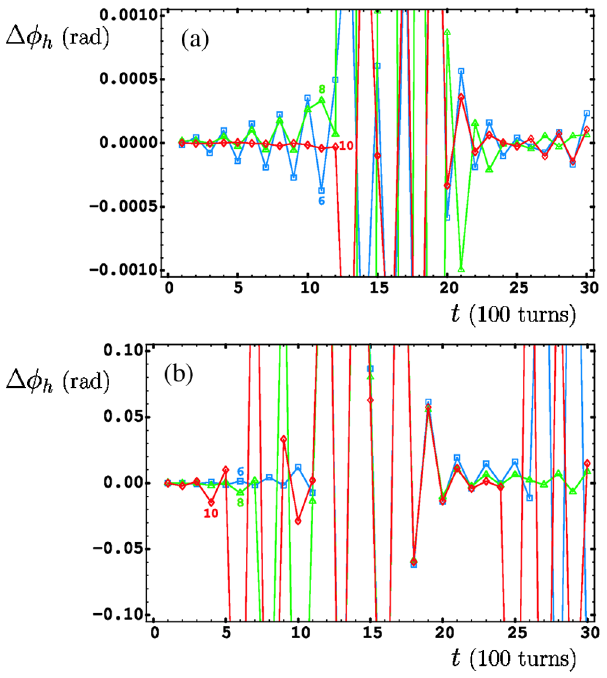
FIG. 8. (Color) Horizontal phase error (cid:26) 0 versus turn h number, in steps of 100 turns, parametrized by Cremona map order (6, 8, and 10), for a comparatively large rela- tive momentum deviation of (cid:29) (cid:1) 7 : 5 (cid:5) 10 (cid:6) 4 . The upper and lower plots show results obtained at amplitudes of 8 (cid:31) and 12 (cid:31) , respectively. That the phase error is largest for the low -order maps at 8 (cid:31) but for the high -order maps at 12 (cid:31) is consistent with the one-turn error results. The large inter- mediate excursions are due to the nonlinear phase-space topology.